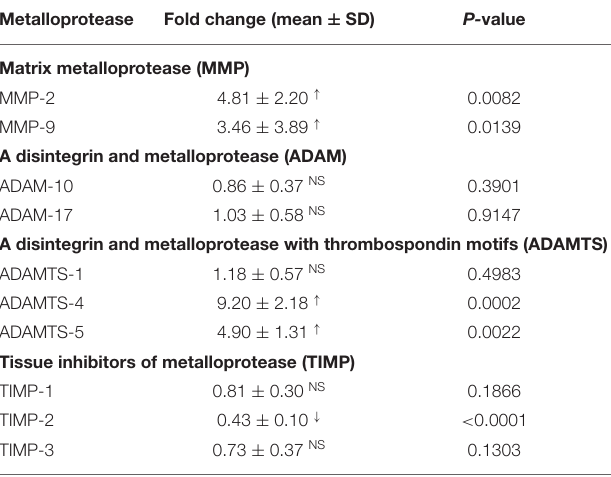
TABLE 3 | Fold changes in the gene expressions of laminar metalloproteases and their inhibitors in the heifers with oligofructose-induced laminitis. Metalloprotease